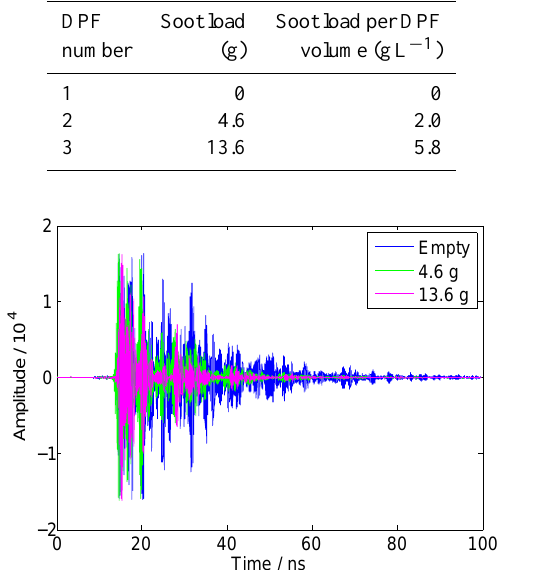
Figure 4. UWB waveforms for three DPFs loaded with different amounts of